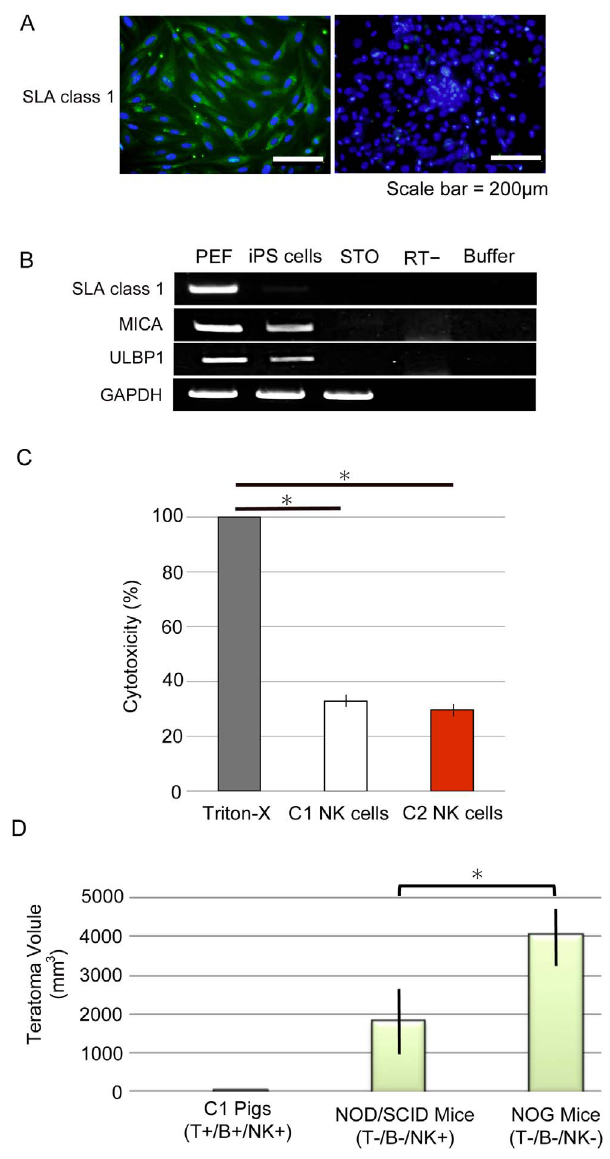
Figure 2. Susceptibility of C1 iPS cells to NK cells. (A) Immunocytochemical staining with an anti-porcine SLA class I antibody. Porcine PEFs showed positive staining for SLA class I, but C1 iPS cells were negative. (B) Reverse-transcription polymerase chain reaction (RT- PCR) analysis of the expression of SLA class I and ligands for NK cells. Lane 1, PEF; 2, C1 iPS cells; 3, STO feeder cells; 4, no reverse transcriptase; and 5, RT-PCR buffer alone. MICA and ULBP1 , ligands for NK cells, were expressed on C1 iPS cells. GAPDH was used as a loading control. (C) Cell injury by NK cells was assessed by measuring LDH released in the supernatants as described in the Materials and Methods. Triton-X (2%) was used as a positive control. The percent cytotoxicity was quantified and shown as mean of triplicate. Two independent experiments were performed and similar results were obtained. (D) Estimated volumes of the teratomas in immunodeficient mice and SLA- matched pigs. C1 iPS cells were transplanted into NK-competent NOD/ SCID ( n =14) and NK-deficient NOG ( n =14) mice, and C1 pigs ( n